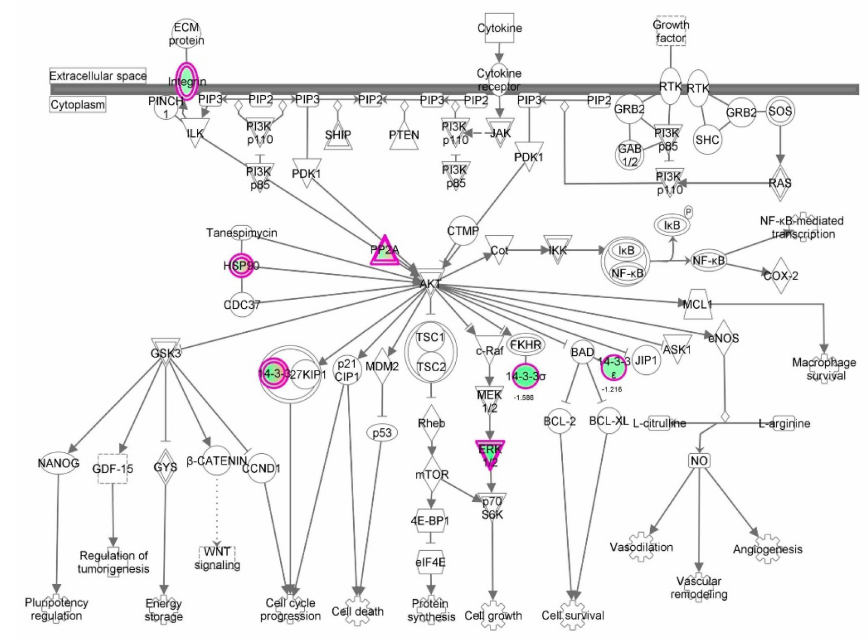
Figure 29. PI3K/Akt signaling pathway was regulated by vancomycin in HK-2 cells. HK-2 cells were treated with 50 µ g/mL vancomycin for 24 h and the protein samples were subject to quantitative proteomic analysis. Red indicates an up-regulation; green indicates a down-regulation. The intensity of green and red colors indicates the degree of down- or up-regulation. Solid arrow indicates direct interaction and dashed arrow indicates indirect